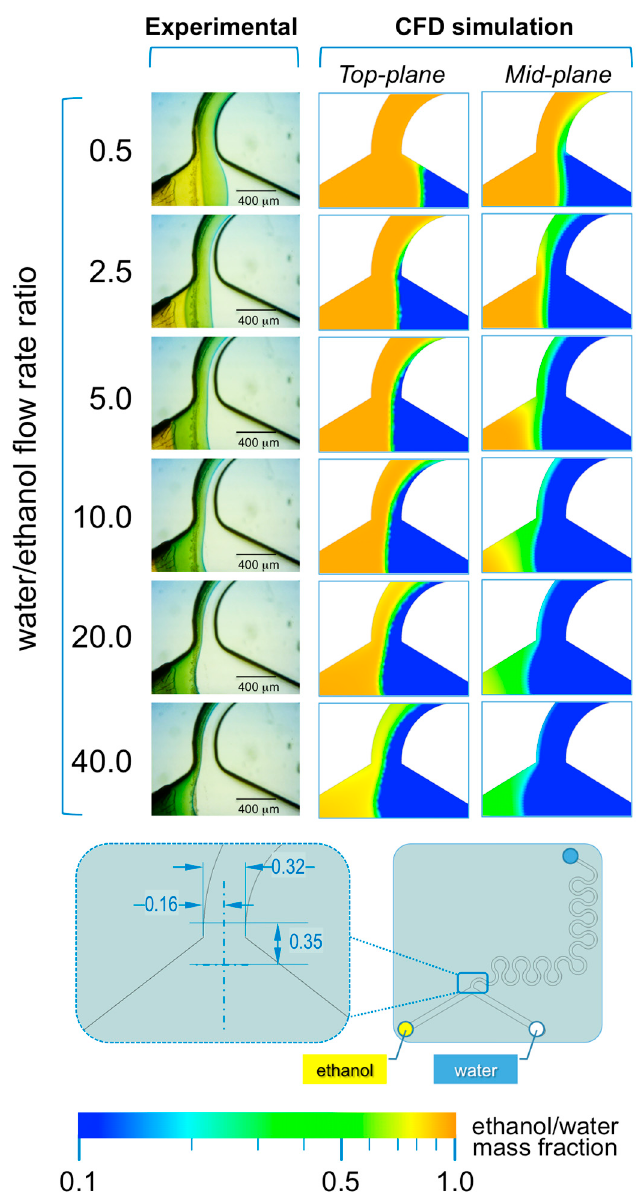
Figure 7. Experimental and computational fluid dynamic (CFD) analysis of the effect of microfluidic parameters on diffusion, diffusion layer width and water/ethanol interface position, in #chip2-YJ. The images illustrate the experimental microscopic observations ( left column ) and the CFD simulations ( mid and right columns ) of the “Y” junction region, at the channels’ intersection; The images were employed to determine the width of the diffusion layer (i.e., the green region) and the water/ethanol interface position, as indicated in the schematic at the bottom; The numerical contours of ethanol mass fraction are reported at both the mid-plane ( mid column ) and top-plane ( right column ) of the device. Experiments and simulations were conducted at TFR of 37.50 µL/min, and at varying FRRs.